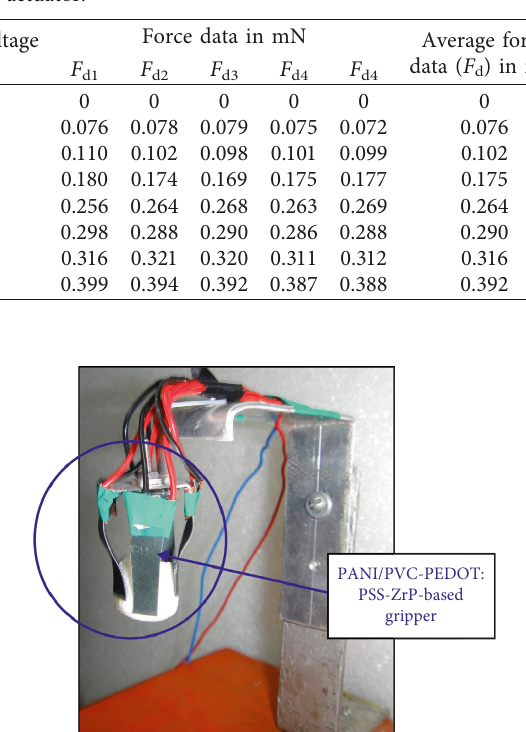
Figure 13: Deflection characteristics of PANI/PVC-PEDOT: PSS- ZrP actuator. Table 4: Experimental force data of the PANI/PVC-PEDOT: PSS- ZrP